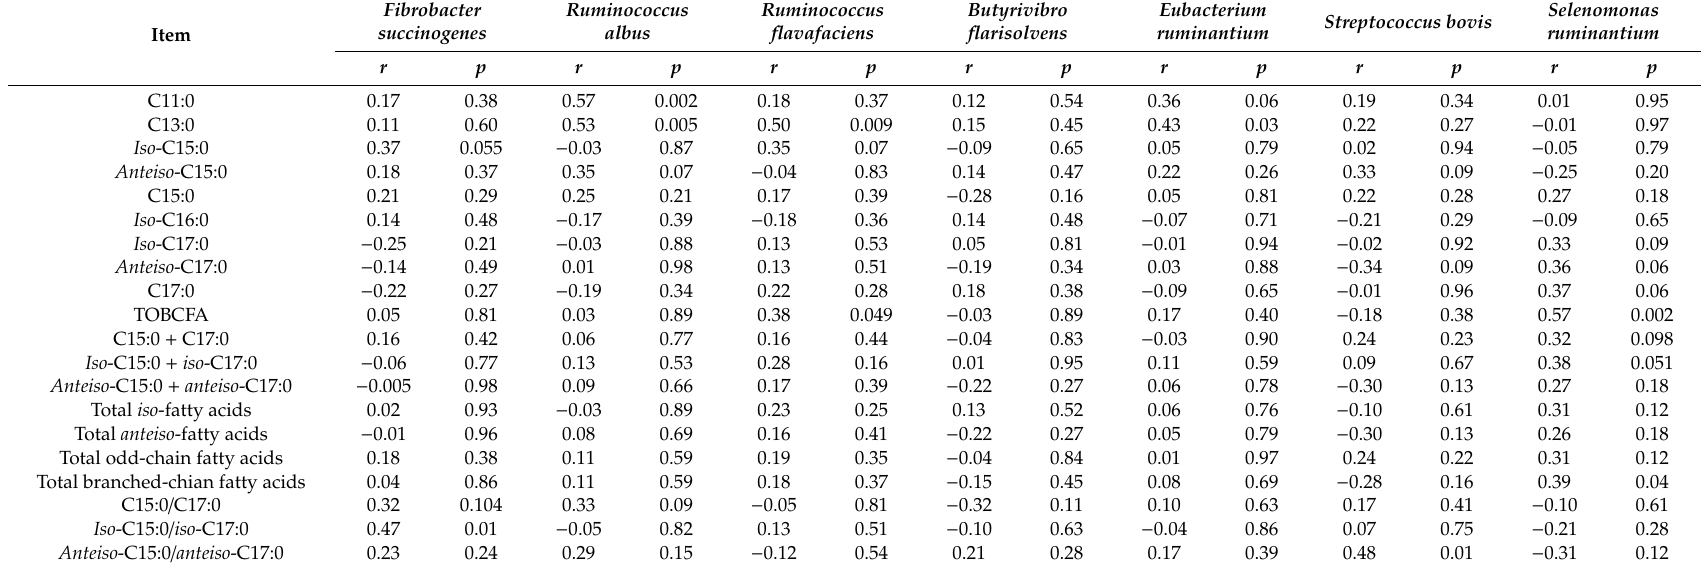
Table 7. Correlation between bacteria populations and milk OBCFA